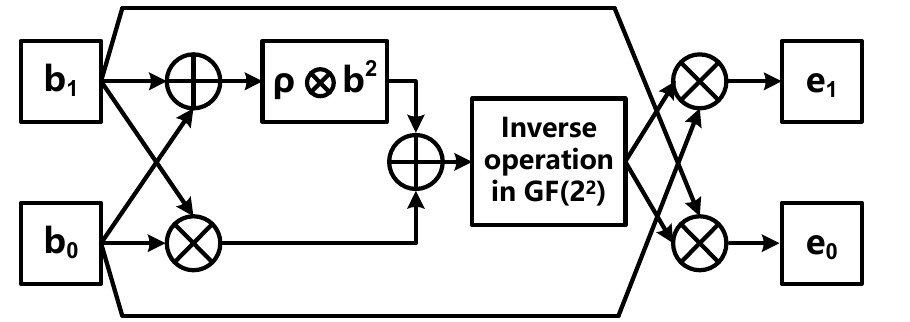
Figure 8. Multiplicative inverse operation of GF(2 4 ) based on regular basis.